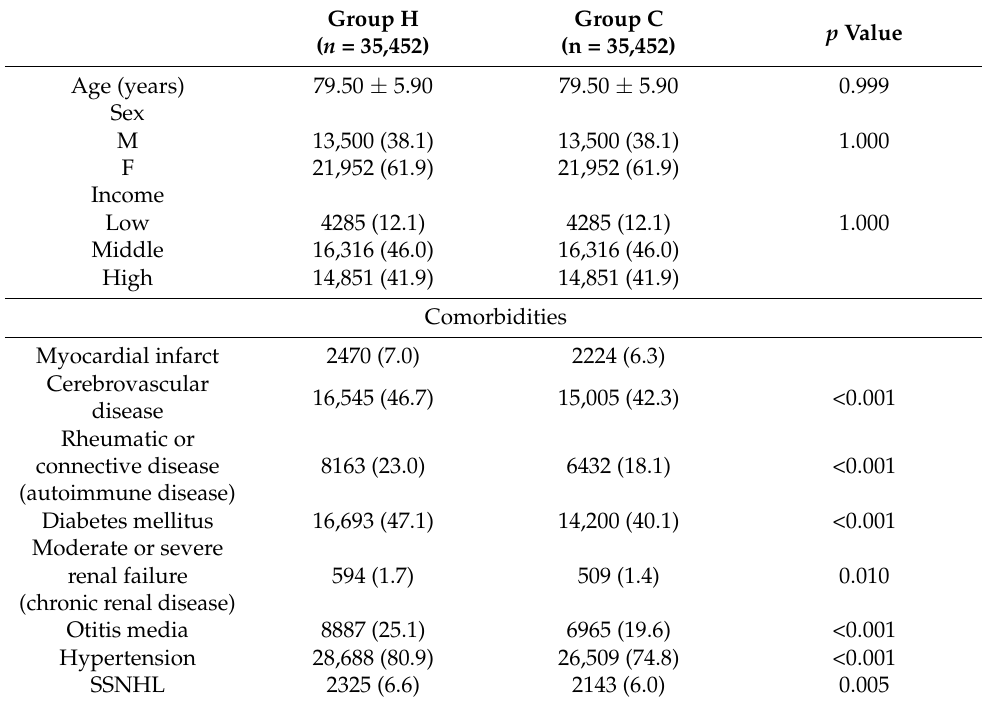
Table 1. Characteristics of the study participants and incidence of comorbidities.